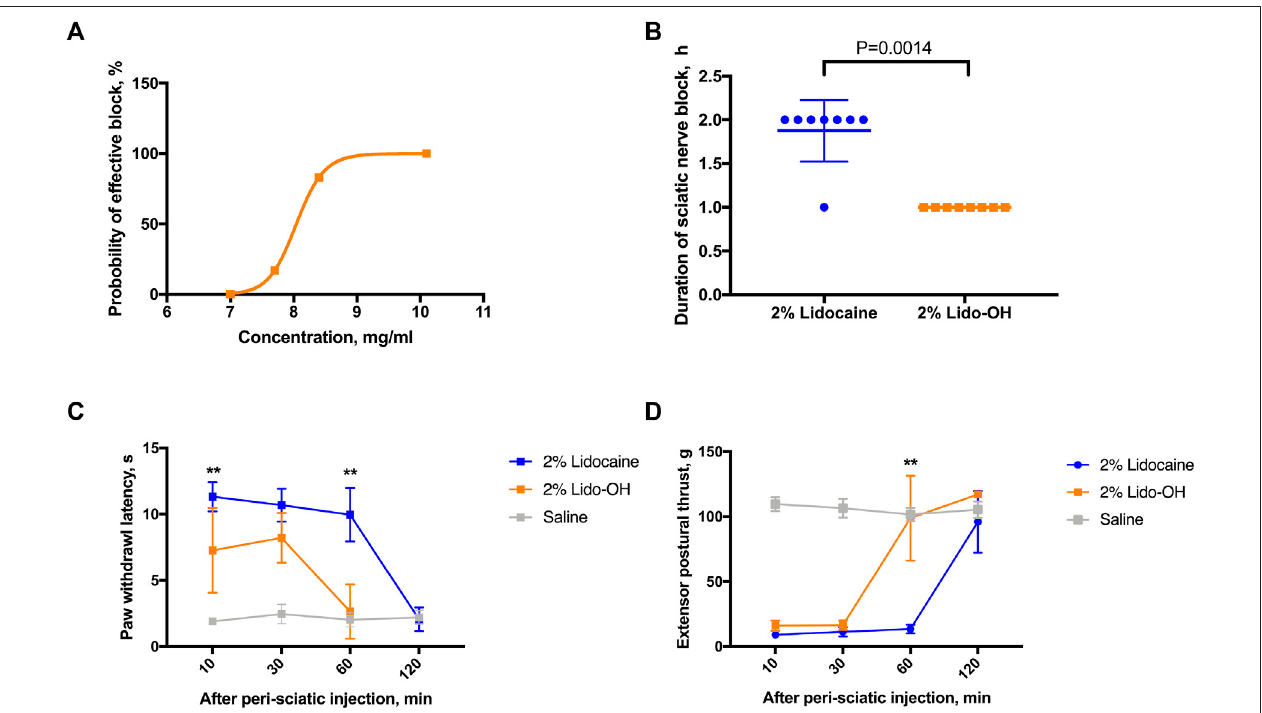
FIGURE4 | The effects oflido-OH and lidocaine inrat sciatic nerve block ( n (cid:1) 8): The concentration-effectivenesscurve oflido-OH (A) ;the duration ofsciaticnerve block (B) ; the magnitude of sensory blockade evaluated by prolonged paw withdrawal latency to noxious heat (C) ; and the magnitude of motor blockade measured by reduction of extensor postural thrust (D) . **: p <